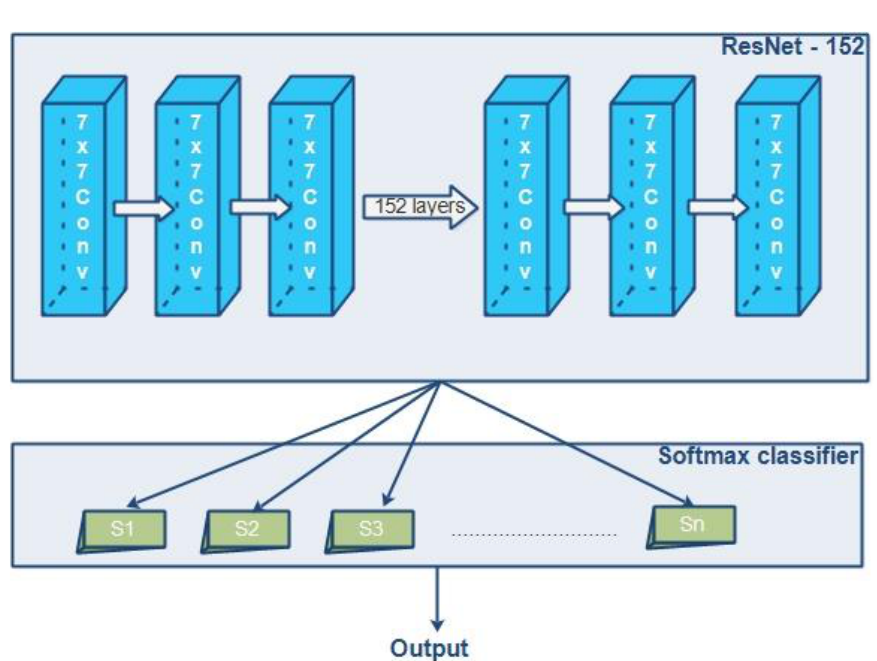
Figure 4. Architectural diagram of ResNet-152 and softmax classifier.